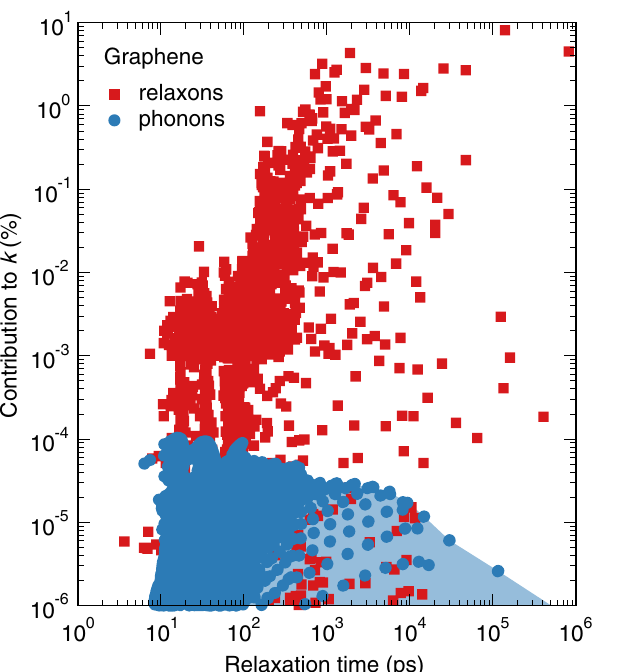
FIG. 4. Comparison of relaxon and phonon velocities and their contributions to the room-temperature thermal conductivity of graphene. When approximating phonons as heat carriers, the velocity scale of thermal transport is set by the speed of sound (about 20 km = s for longitudinal acoustic phonons in graphene). Instead, relaxon velocities are at least an order of magnitude smaller, illustrating how much the phonon scattering slows down the heat